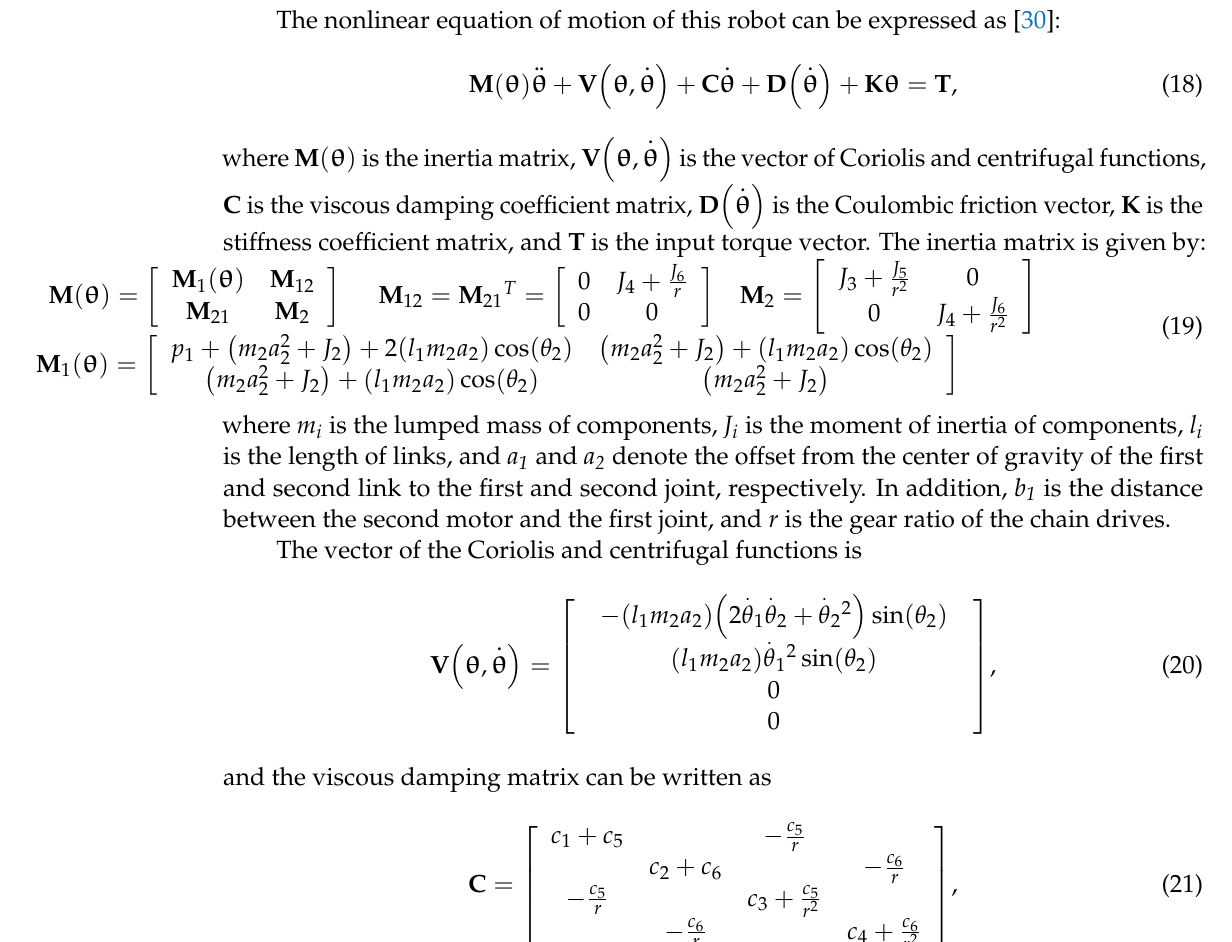
Figure 3. The two-link flexible-joint robot manipulator: physical photograph (left), top-view schematic diagram (right).